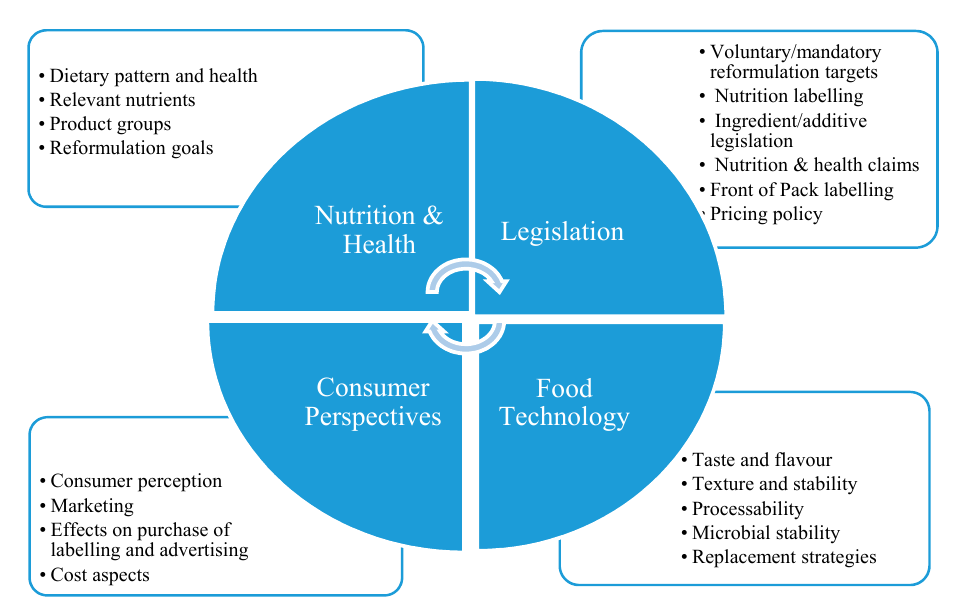
Figure 1. The four disciplines of a reformulation process and main topics per discipline. Disciplines: Nutrition & Health, Food Technology, Legislation and Consumer Perspectives [21].